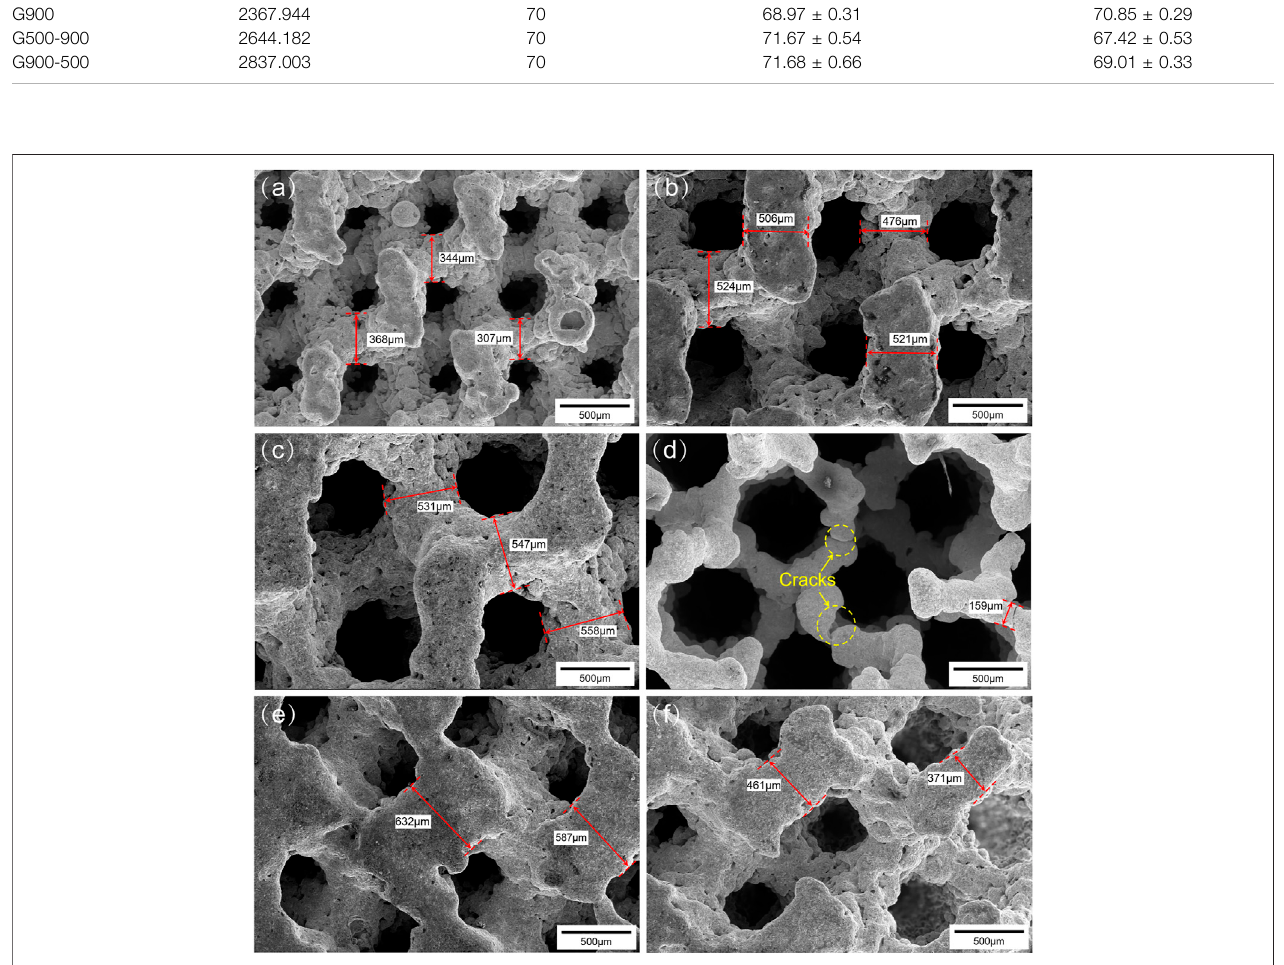
FIGURE 4 | Surface morphologies of the scaffolds: (A) G500, (B) G750, (C) G900, (D) G900-500, (E) and (F) G500-900.